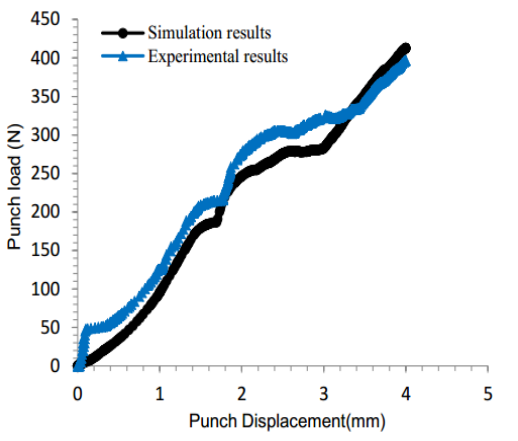
Fig. 15. Thickness distributions of wall cup transverse direction.